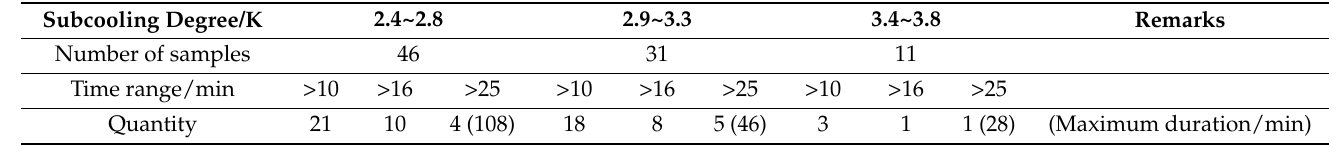
Table 3. Duration distribution.